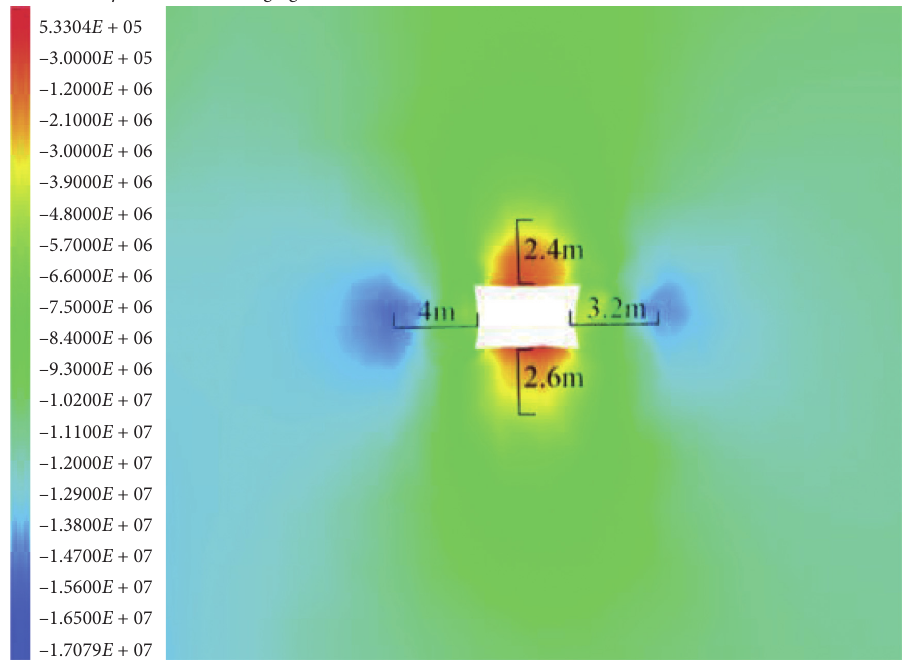
Figure 5: The vertical stress distribution of surrounding rock in the haulageway of No. 3318 working